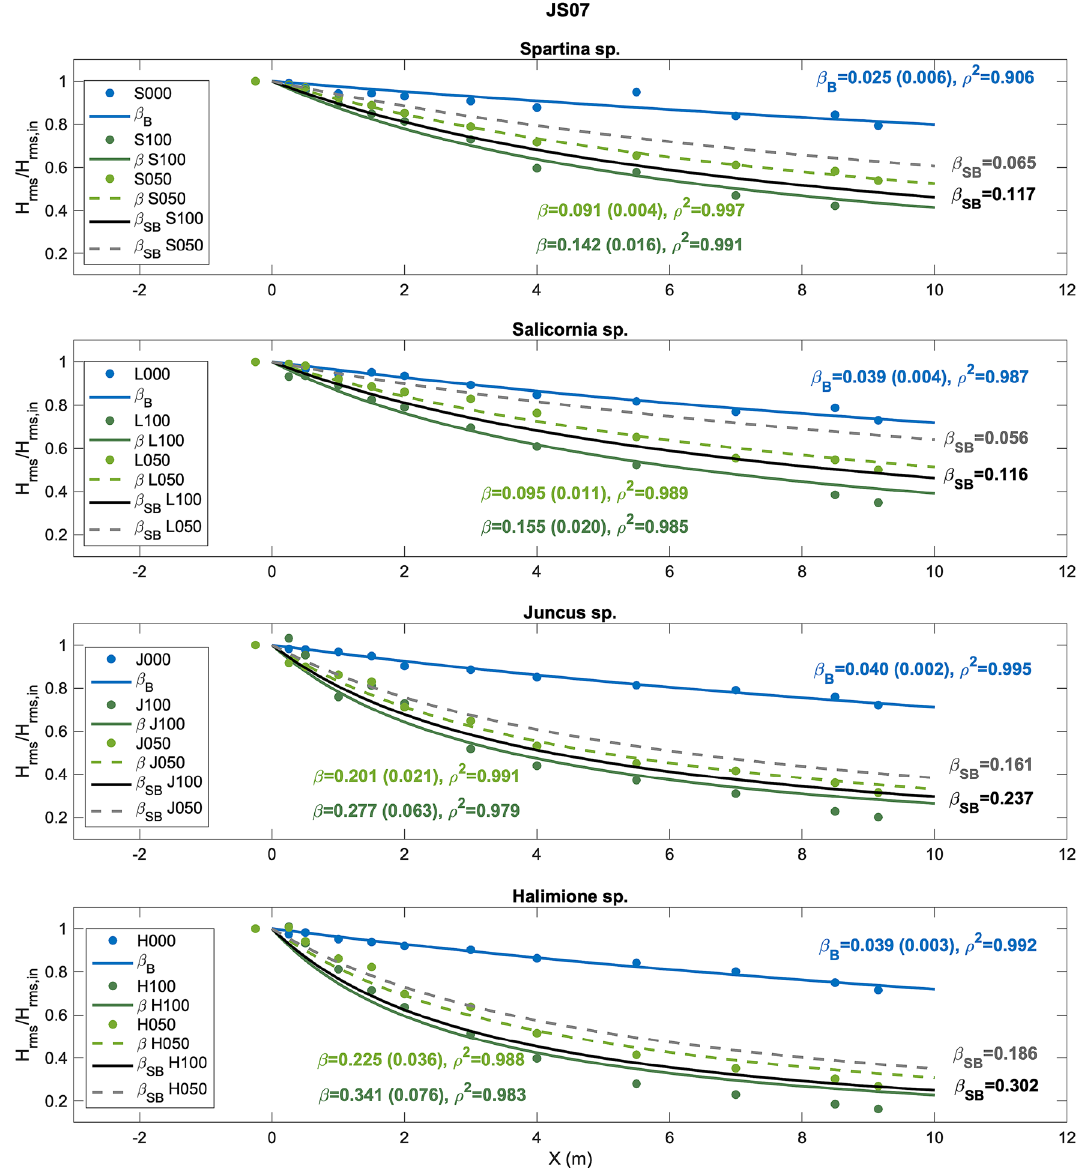
Figure 2. Analysis of wave attenuation under wave condition JS07 for Spartina sp. 100% (S100), 50% (S050) and zero density (S000); Salicornia sp. 100% (L100), 50% (L050) and zero density (L000); Juncus sp. 100% (J100), 50% (J050) and zero density (J000); and Halimione sp. 100% (H100), 50% (H050) and zero density (H000). The damping coefficients for the bare soil cases, β B , are displayed in blue. The damping coefficients for the 100% and 50% density cases, β , are displayed in dark and light green, respectively. The damping coefficients obtained after subtracting the dissipation obtained in the bare soil cases, β SB , are displayed in black and dark gray. 95% confidence interval is shown in brackets and correlation coefficient ( ρ 2 ) for each fit is also